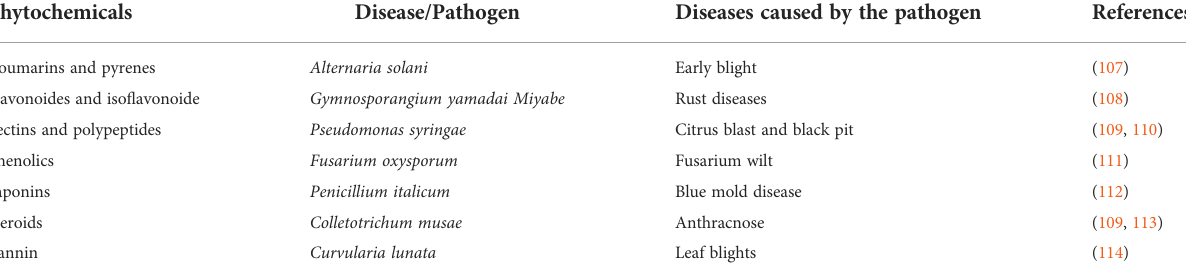
TABLE 2 Phytochemicals found in underutilized legumes and their potentials against plant diseases.